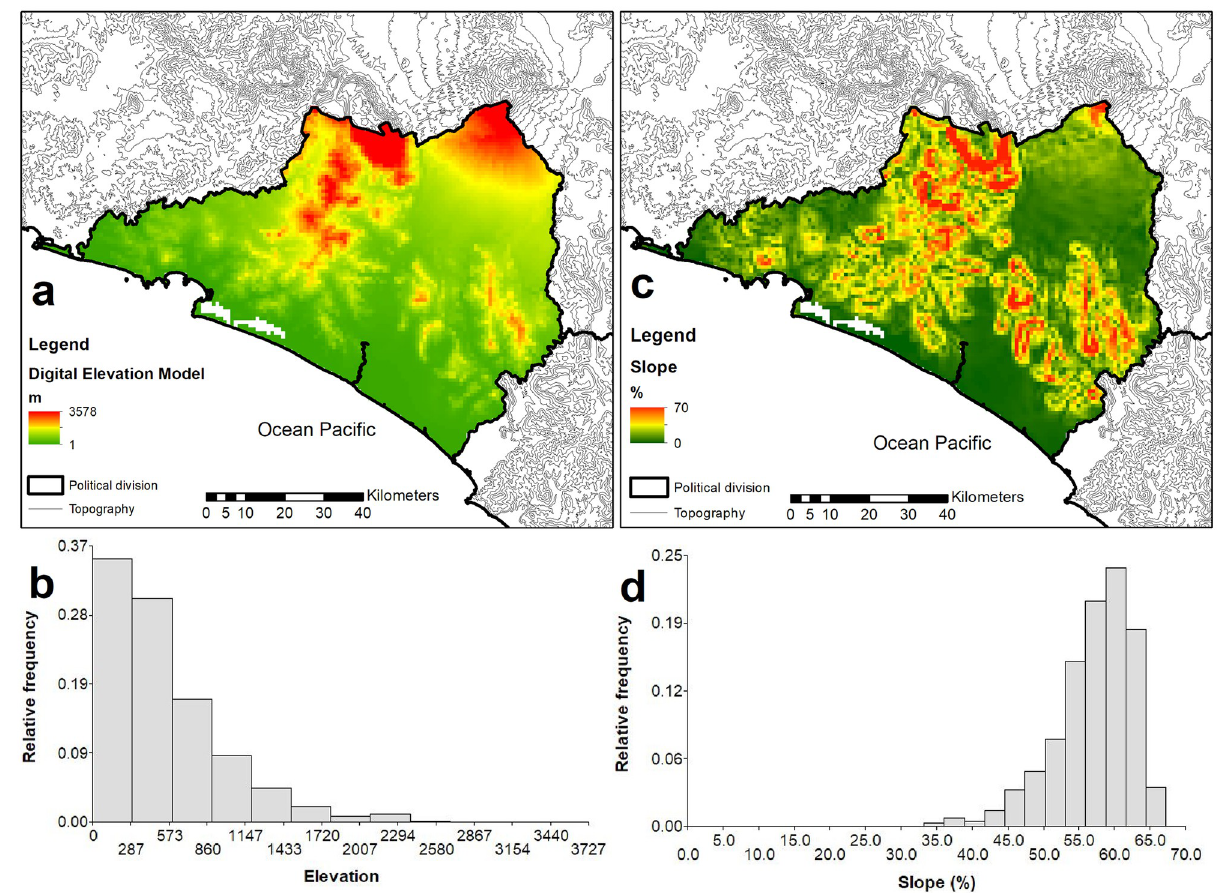
Fig 7. Histogram and spatial distribution of elevation and gradient (percent of slope) across Colima, Mexico. Maps were created by J.F.G.M. using ArcGIS 10.2.1. software (https://www.esri.com).